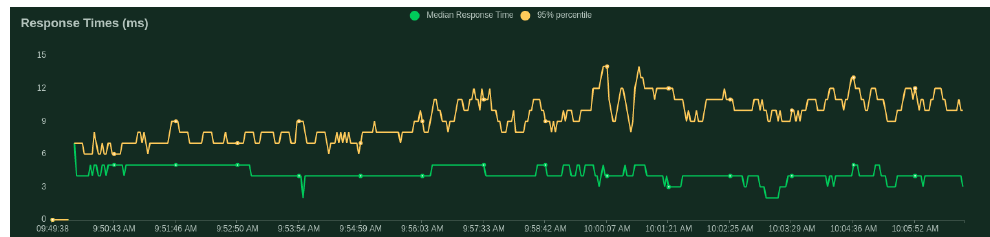
Figure 4. Response times (ms) per number of users.